Question: Sum up the contents of this chart in one sentence.
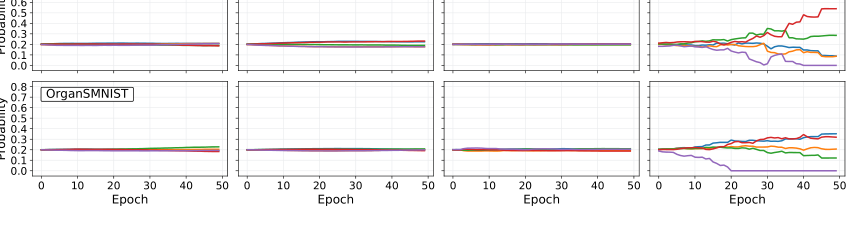
Answer: Probability rank variation of one edge during the search procedure.